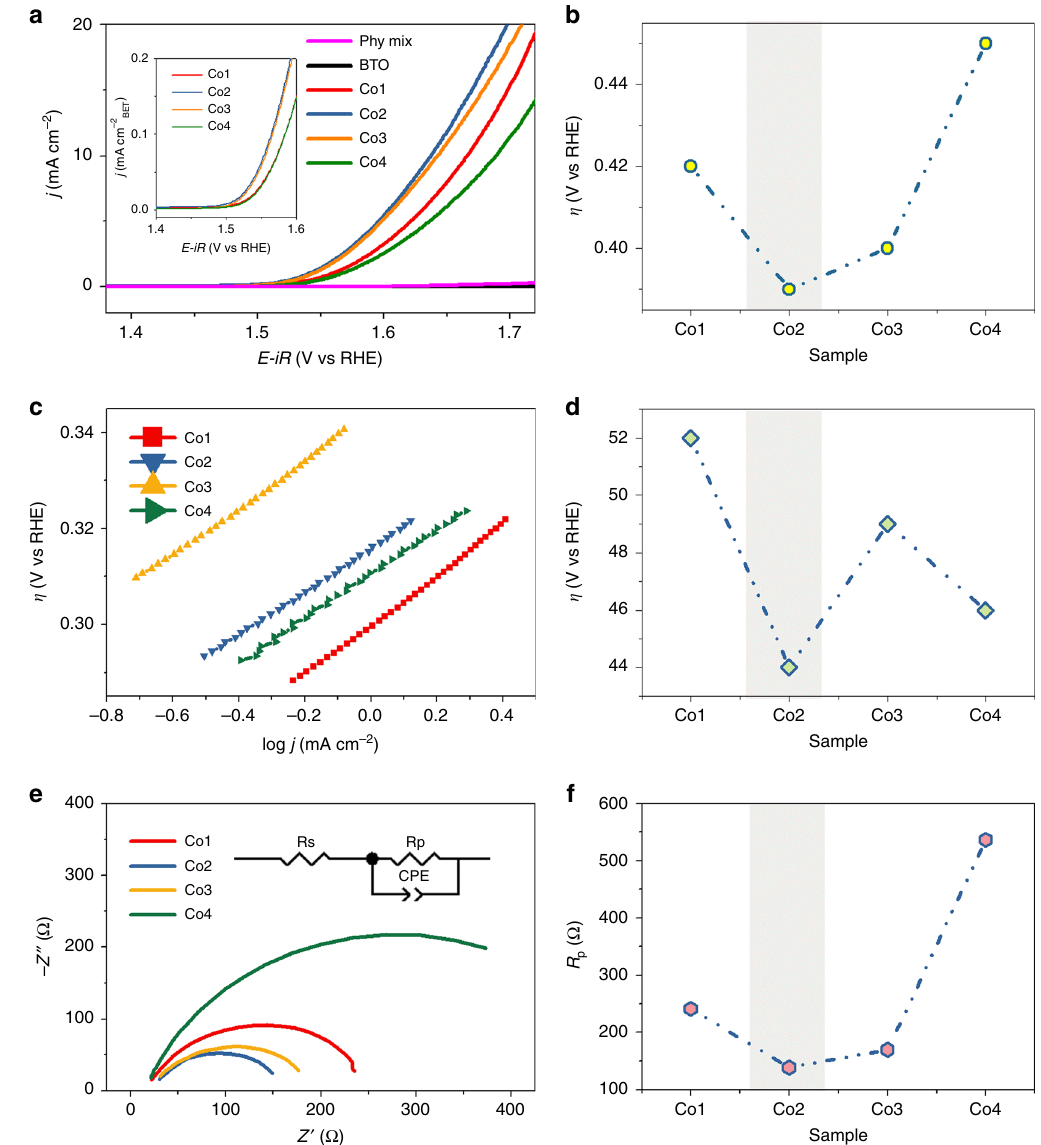
Fig. 3 Electrocatalytic characterization for the OER. a LSV curves obtained at the scan rate of 5 mV s -1 ; the inset is the corresponding normalized curve based on the BET surface area; b overpotential of the four samples at η j = 10 ; c Tafel plots; d Tafel slopes of the four samples; e Nyquist plots, with the inset showing the equivalent circuit; and f polarization resistance ( R p ) of the four